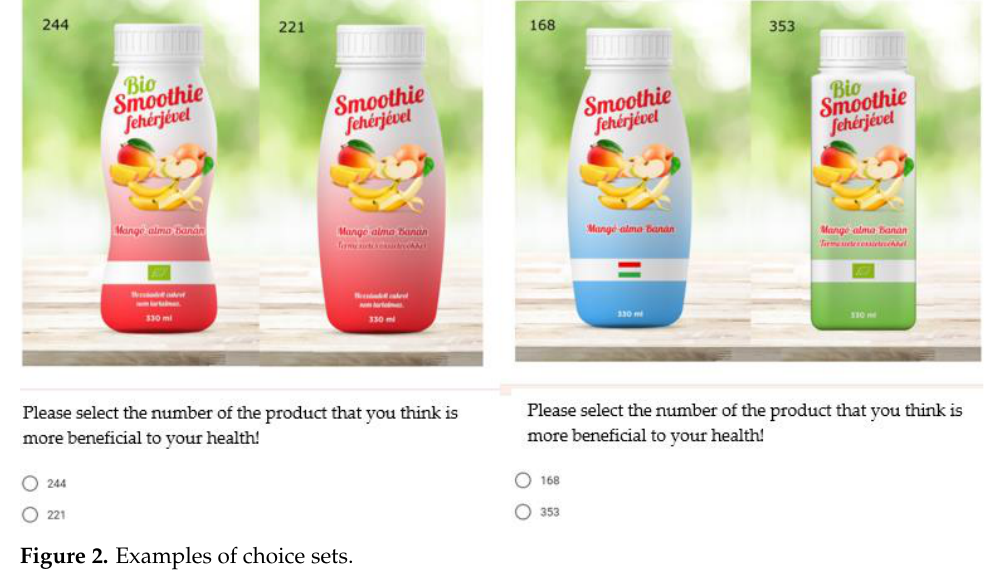
Figure 2. Examples of choice sets.